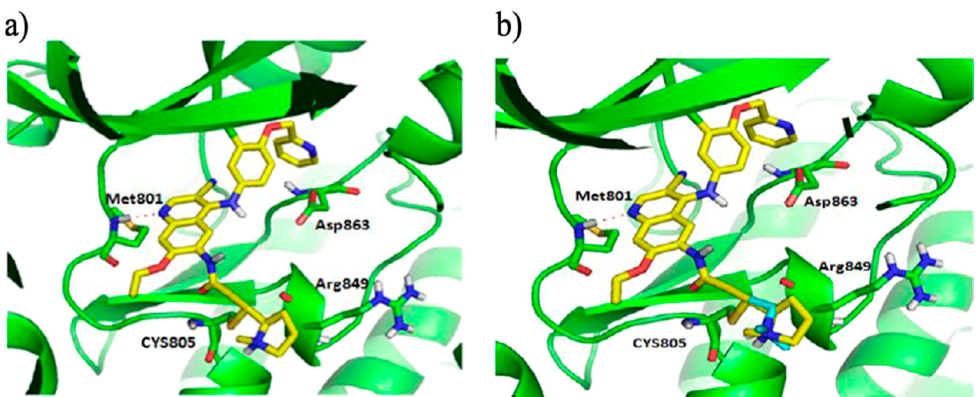
Figure 20. ( a ) binding mode of pyrotinib in the catalytic region of HER2 kinase; ( b ) overlap binding mode of neratinib (colored blue) and pyrotinib (colored yellow) [114].